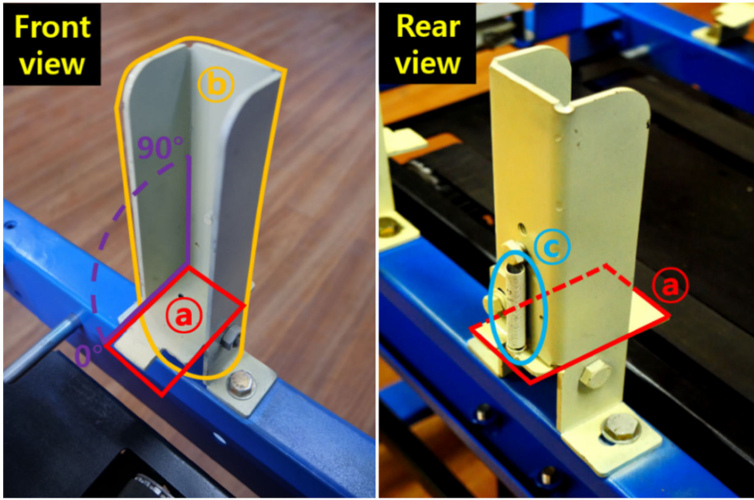
Figure 8. View of stopper bracket: ( a ) bracket, ( b ) guide, and ( c )